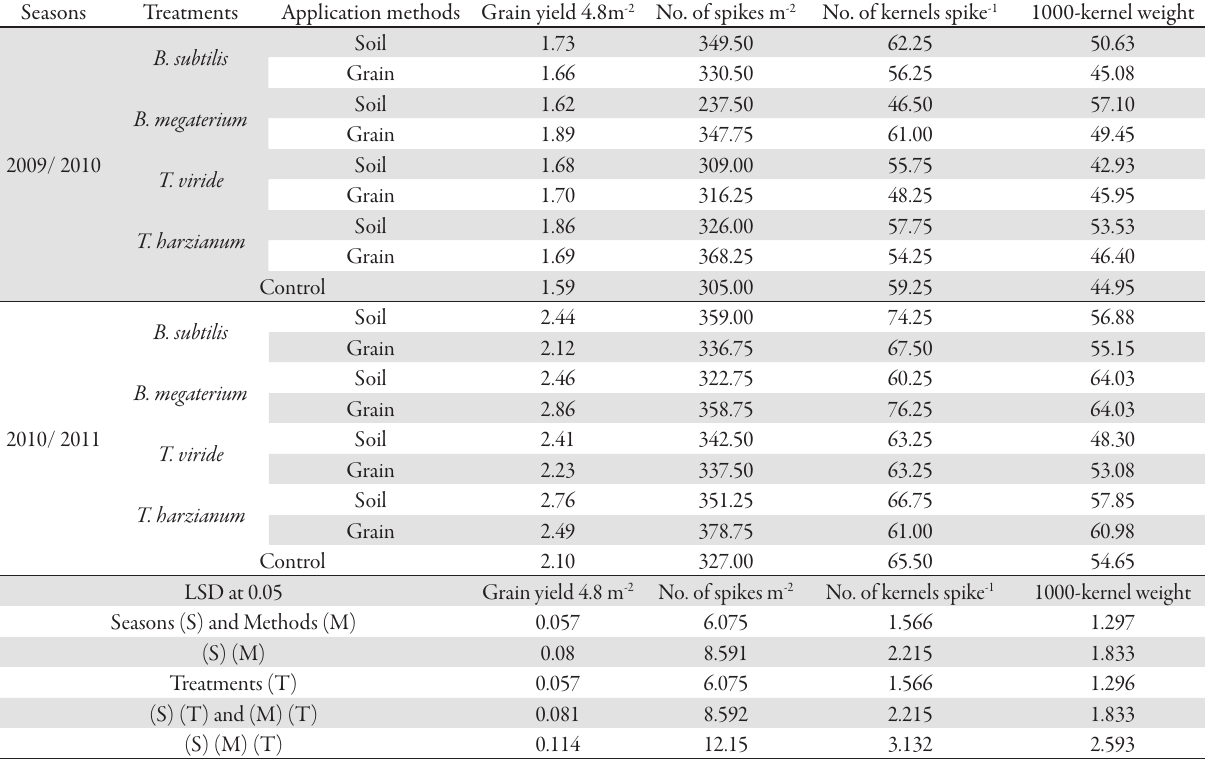
Tab. 7. Effect of bio-control against on grain yield (Kg 4.8 m -2 ), No. of spikes m -2 , kernels spikes -1 and 1000-kernel weight for ‘Sakha 93’ bread wheat cultivar in 2009/2010 and 2010/2011 seasons Seasons